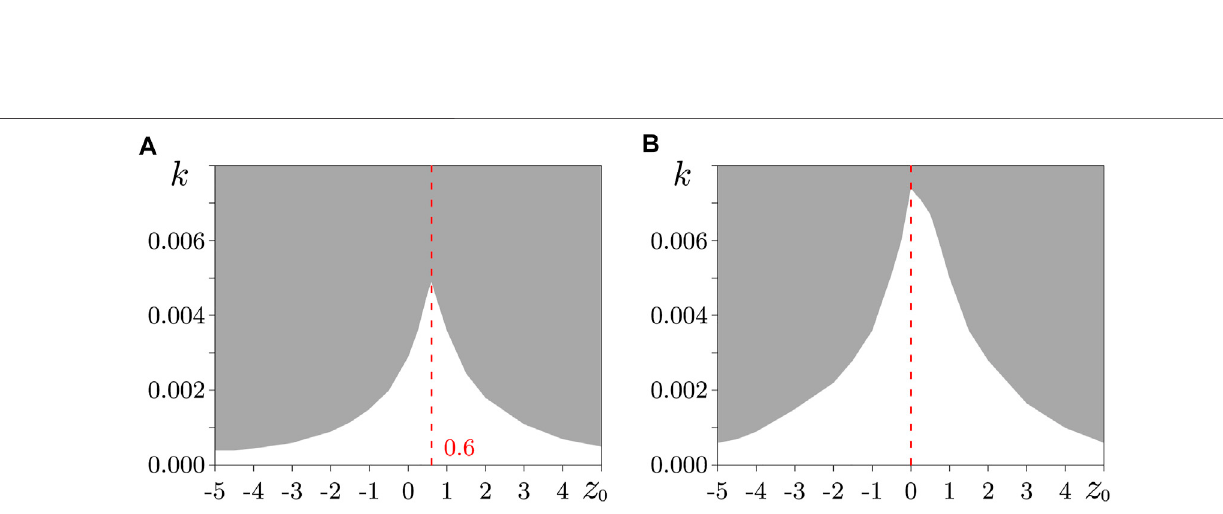
Frontiers in Physics |